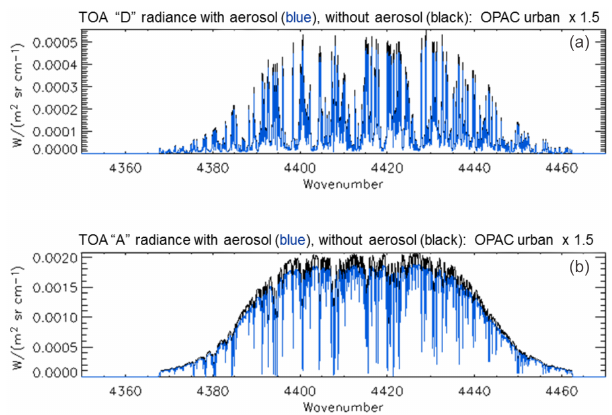
Figure 7. Forward-model results with aerosol loading. Simulated radiance spectra for CHRONOS corresponding to TOA D (a) and A (b) signals with the CHRONOS CH 4 SWIR channel band pass applied. Simulations are for a midlatitude summer atmosphere with solar zenith angle = 0, satellite zenith angle = 40 ◦ and surface albedo = 0.2. Black lines represent the case without aerosol scatter- ing, and blue lines show radiances with aerosol scattering for urban aerosols (AOD is 0.089, which is obtained by scaling the OPAC ur- ban aerosol case by 1.5). D/A is computed after integration over the band pass and is changed by − 0.039% for the case with aerosols compared to without.